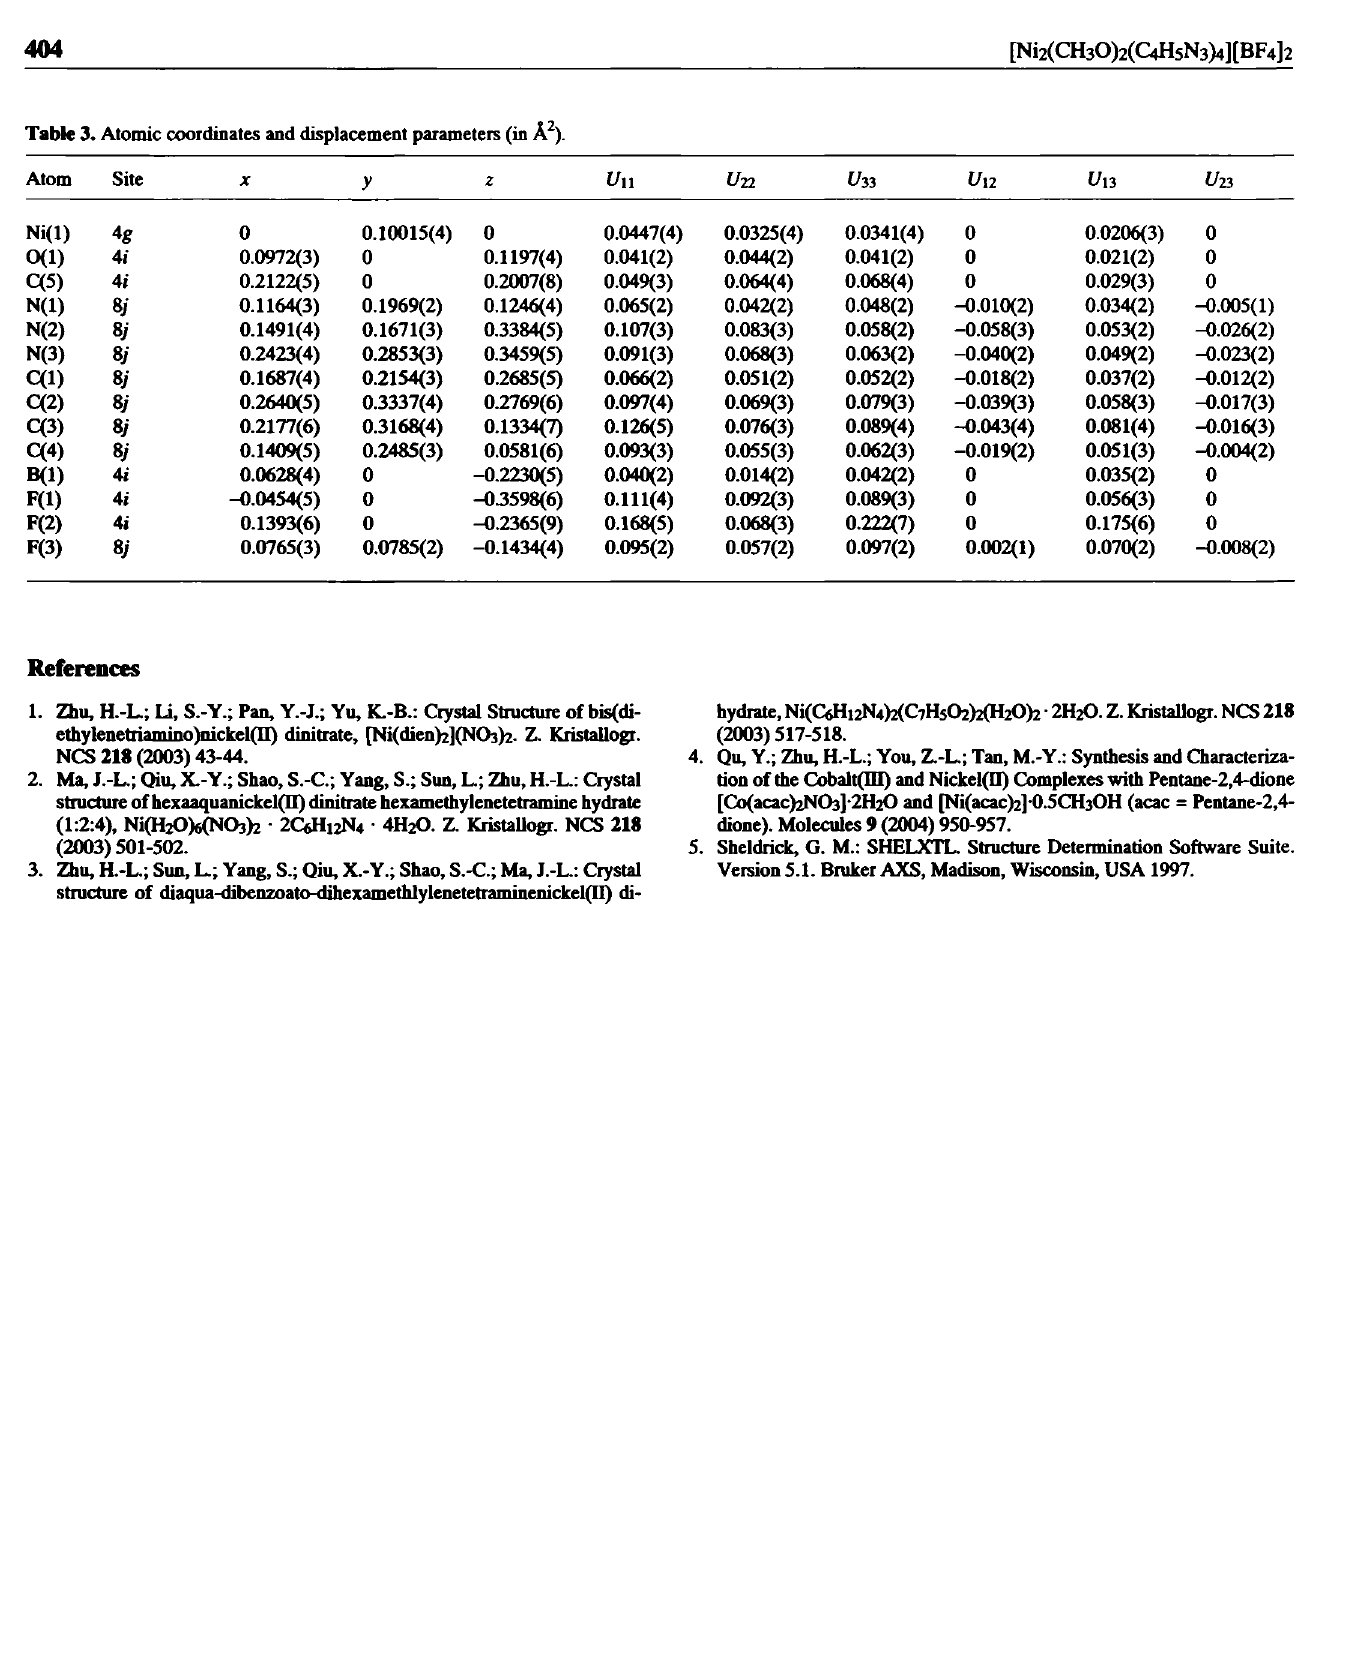
Table 3. Atomic coordinates and displacement parameters (in A 2